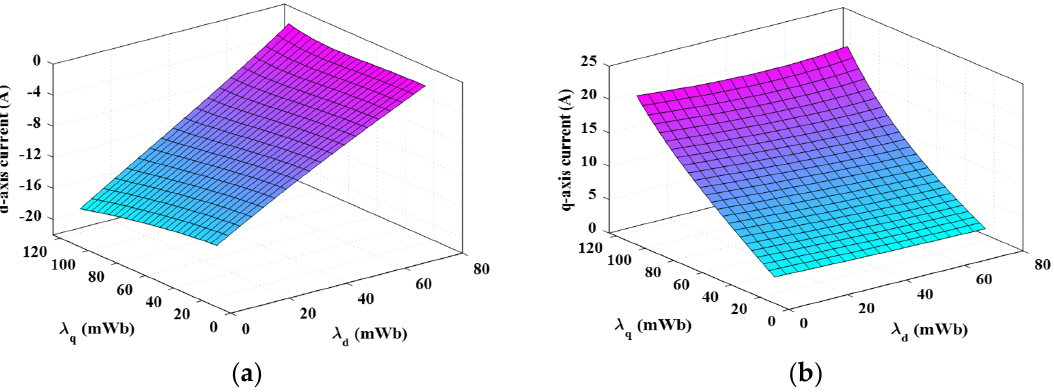
Figure 8. The current maps: ( a ) d-axis current, ( b ) q-axis current.